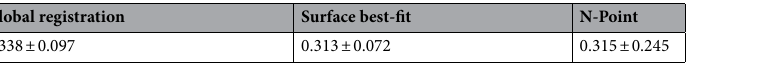
Table 1. Mean ± standard deviation of the volumetric error [%] of the 3 consecutive scans of a lower limb of 4 not-amputated subjects, for the three alignment tools of the VXmodel